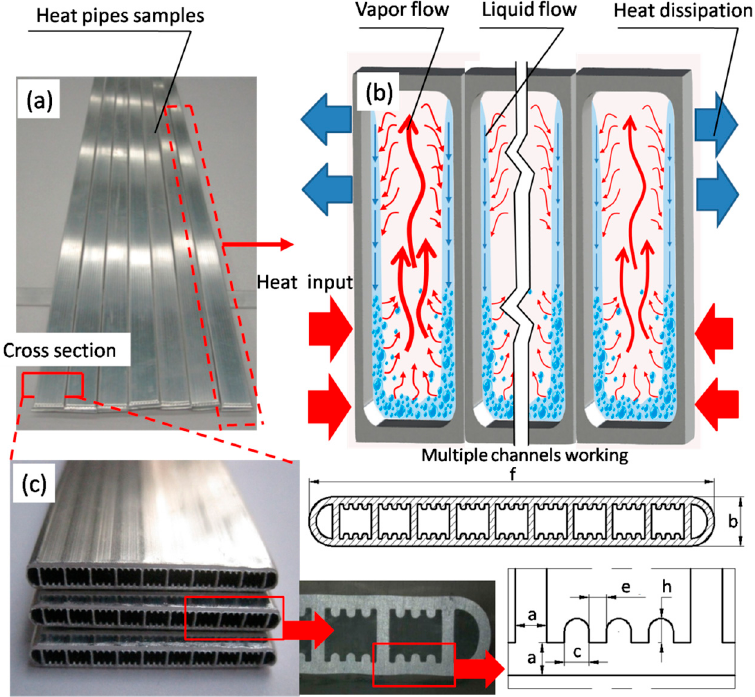
Figure 1. Geometric configuration and working mechanism of the micro flat aluminium heat pipe arrays (MF-AHPA). ( a ) Real image of the MF-AHPAs; ( b ) multiple channels working mechanism; and ( c ) geometric configuration of the MF-AHPA shell.